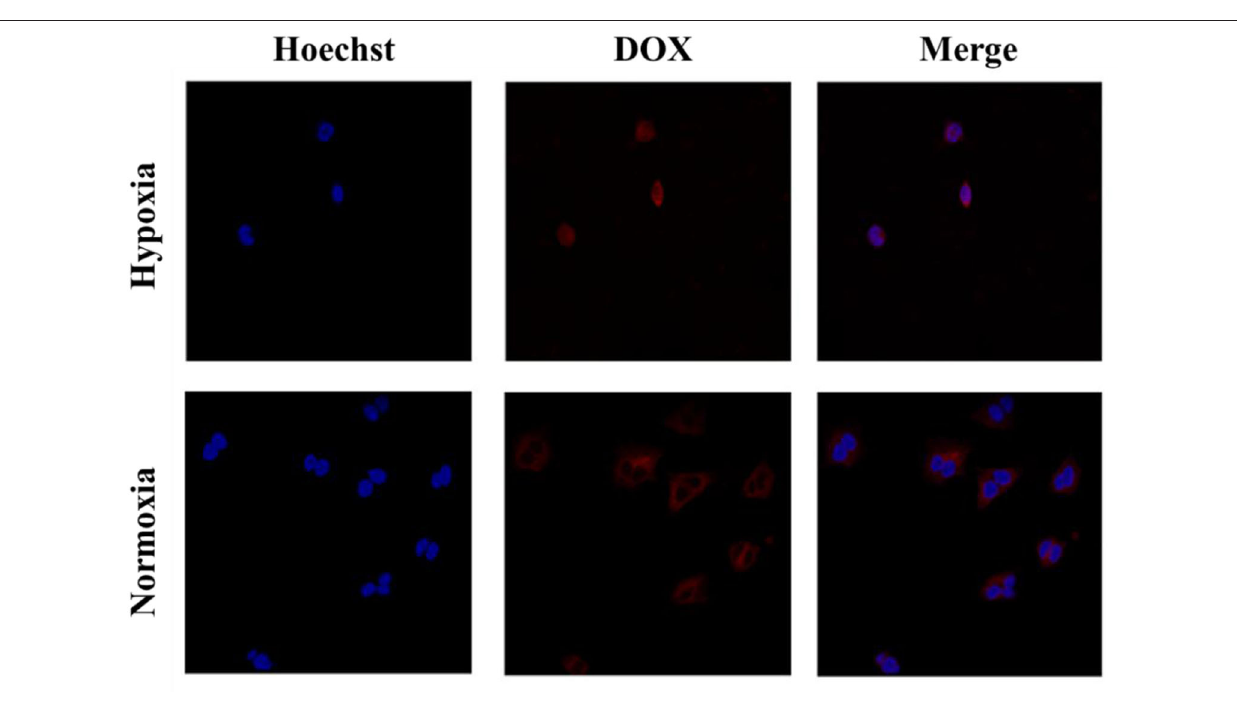
FIGURE 3 | Cellular uptake of PEGN/DOX after being cultured with MCF-7 cells for 2h under hypoxic conditions and normoxic